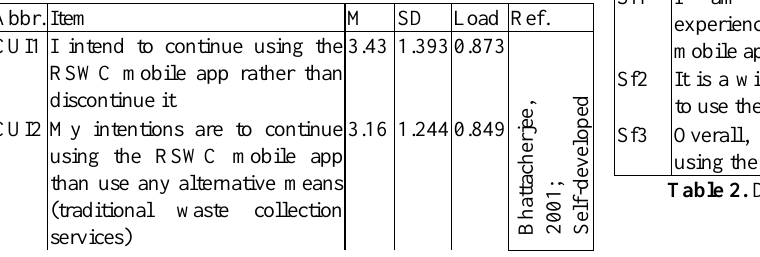
Table 2. Descriptive statistics and factor loadings of